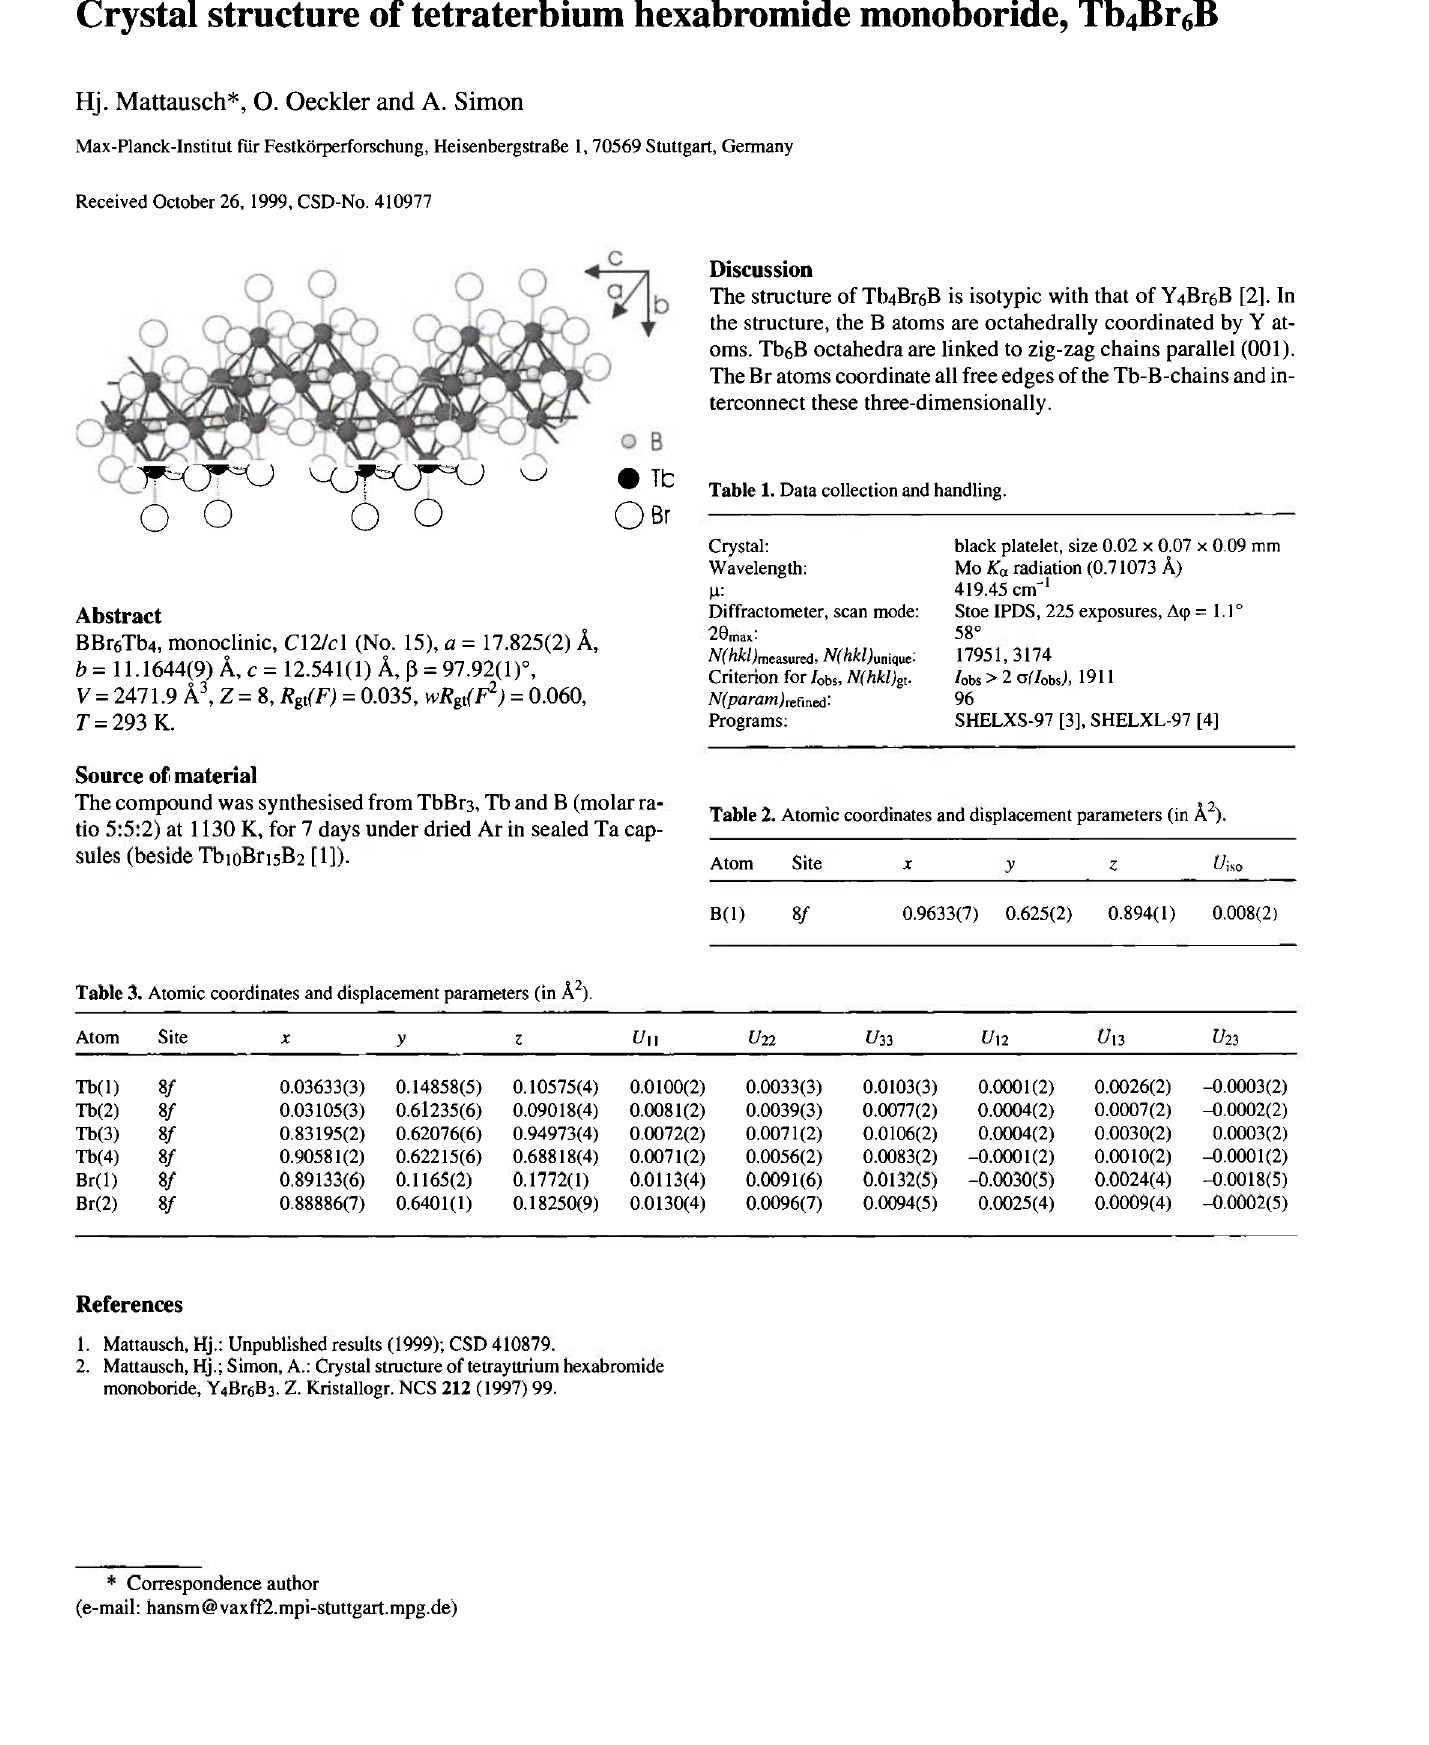
Table 1. Data collection and handling.